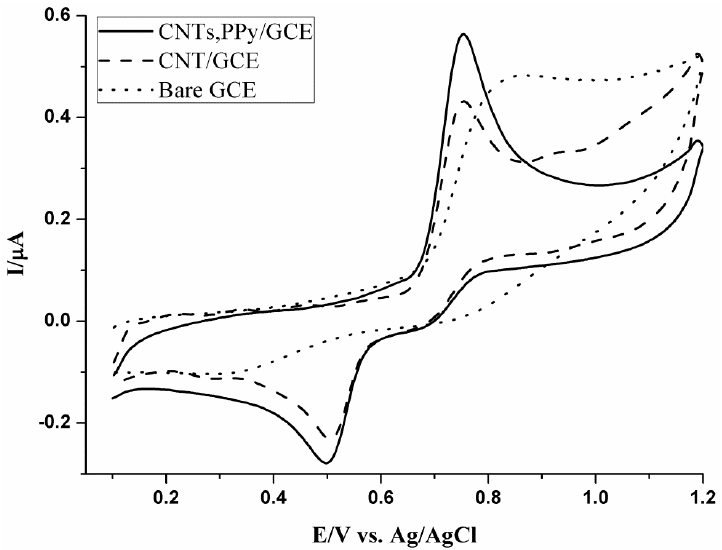
Figure 3. Cyclic voltammograms of 3.22 × 10 − 5 M FA on bare GCE, MWCNTs/GCE, and PPy-MWCNTs/GCE in 0.2 M H 3 PO 4 (pH 2.54) at a scan rate of 20